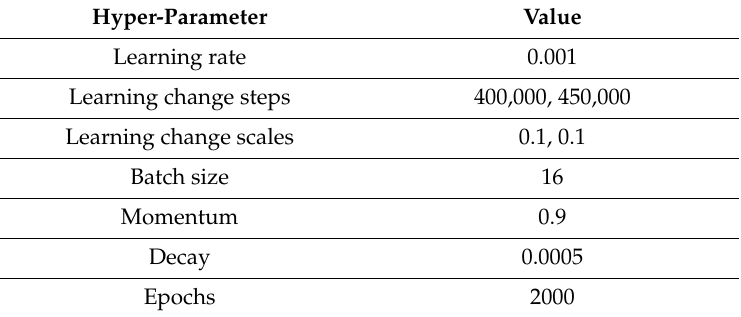
Table 3. Hyper-parameters for training CFF-SDN model. The optimizer used in model was